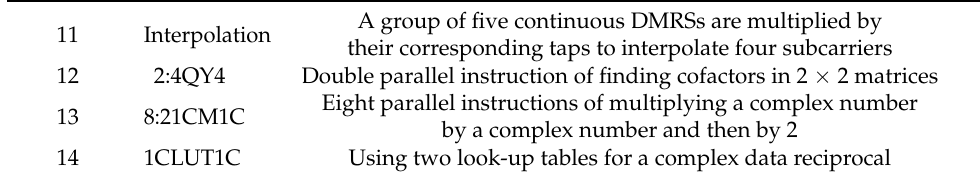
Table 3. Dedicated acceleration command for channel estimation module.